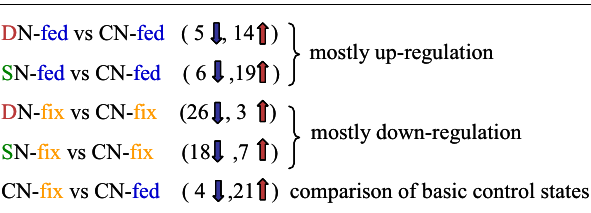
FIGURE 3 | Summary of the number of up- or down-regulated shoot compounds (proteins and metabolites) of the different treatments. Compounds, mostly up-regulated in N-fed and mostly down-regulated in N-fix plants during stress (independent on stress condition). D, drought; C, control; S, salt; N-fed, nitrogen fertilization; N-fix, nitrogen